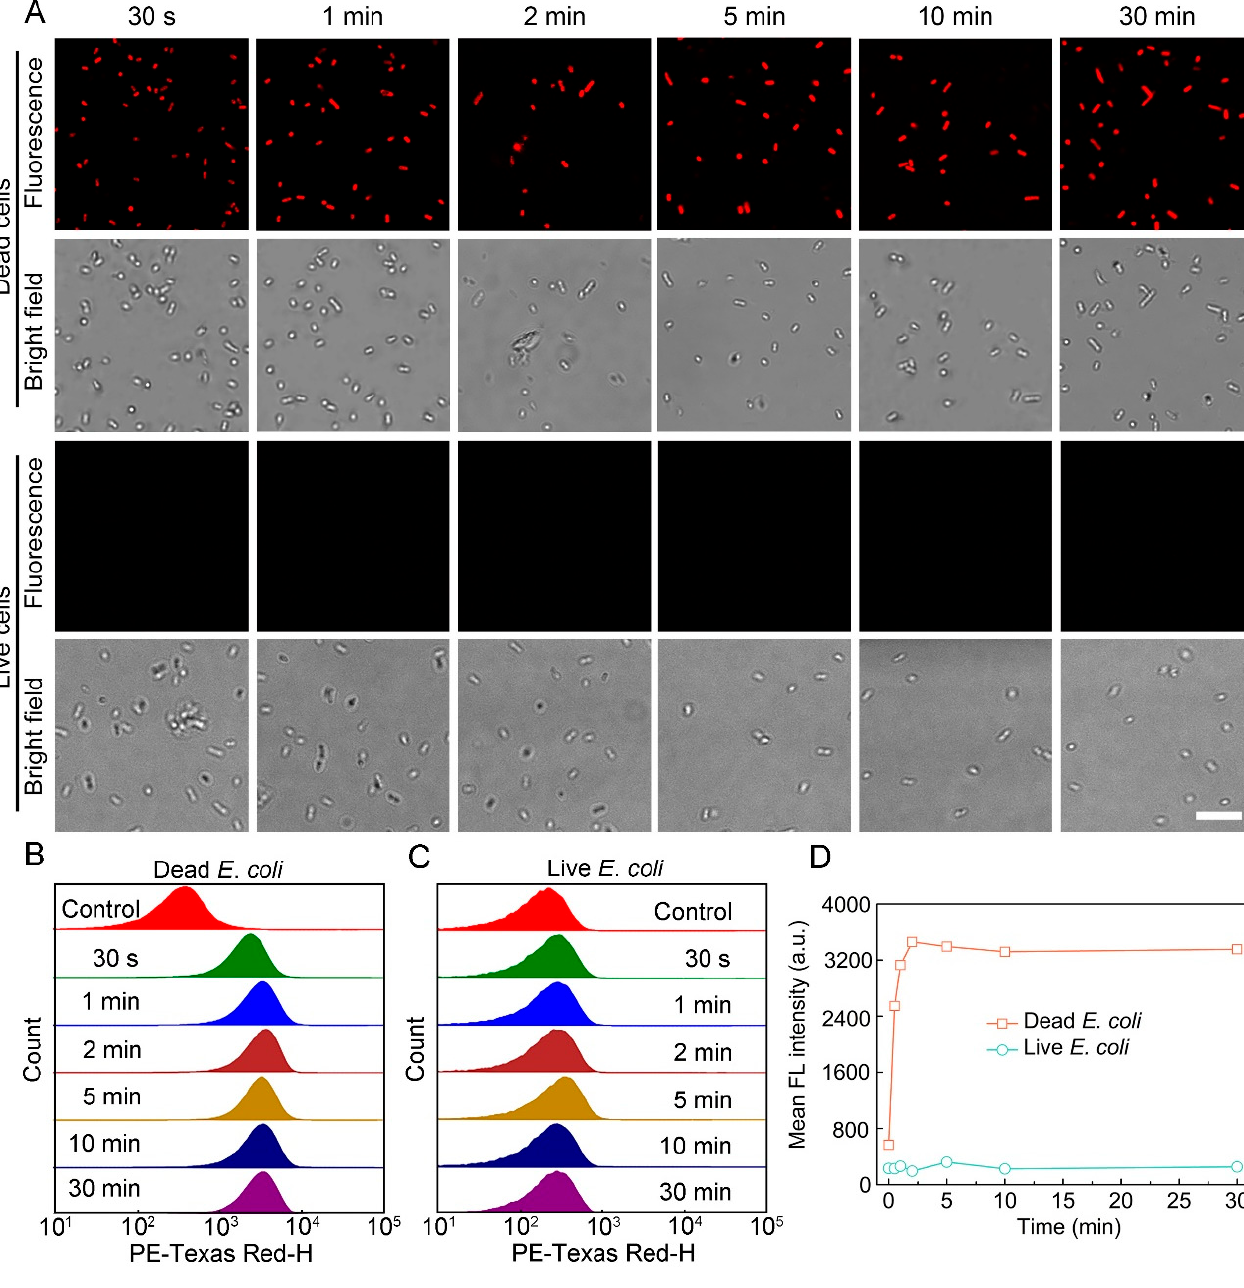
Figure 3. ( A ) Confocal images of dead and live E . coli cells treated with S-OSiNDs (5 μ g/mL) for different time periods. Scale bar = 10 μ m. Flow cytometric results of dead ( B ) and live ( C ) E . coli cells incubated without (control) or with S-OSiNDs (5 µ g/mL) for different time periods and ( D ) corre- sponding quantitative mean fluorescence intensities derived from the flow cytometric results.